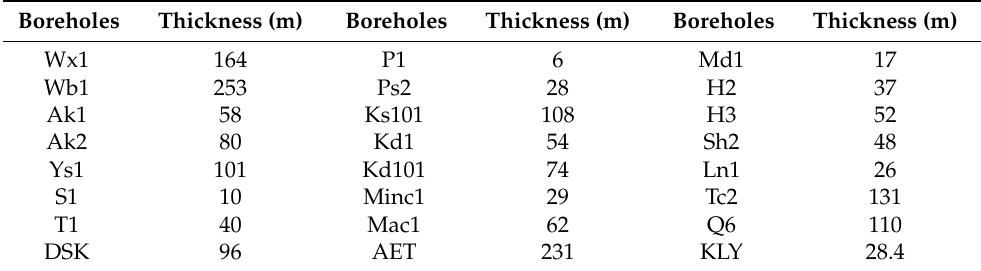
Table 3. Thickness of gypsum in the Yarkand Basin in the Paleocene. Boreholes Thickness (m) Boreholes Thickness (m)